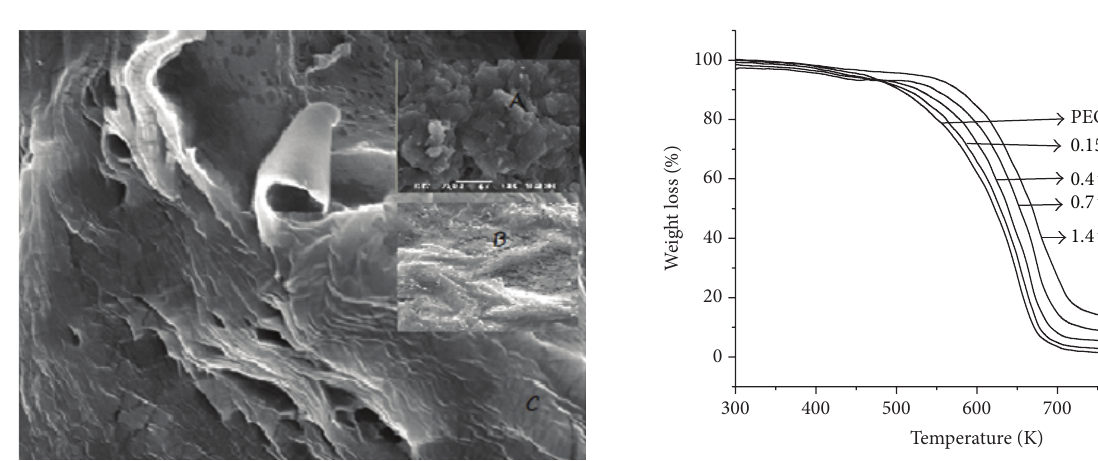
Figure 3: TGA of pure PEO with different GO concentration.